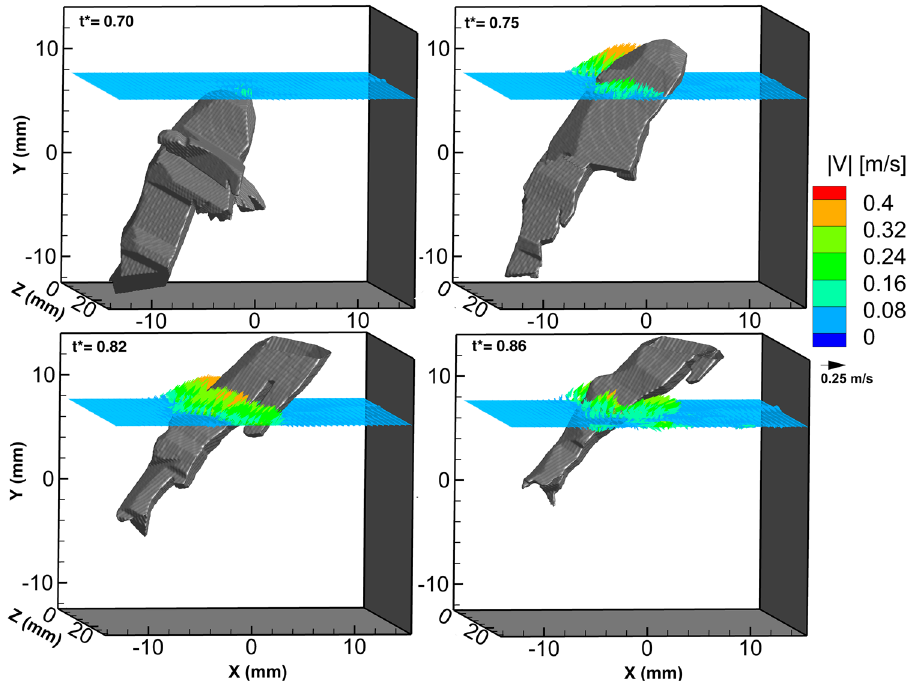
Figure 3. Time sequence of the fluid velocity field in a XZ plane while E. superba performs the tail flip and abdominal closure and accelerates to the upper right region of the viewing window. The non-dimensional time point is labeled in each frame. The velocity vectors are colored to indicate the fluid velocity magnitude, as defined in the legend. At time point t* = 0.70, the animal is executing the tail flip, and during the time period t* = 0.75–0.86, the krill has completed the abdominal closure and its velocity is